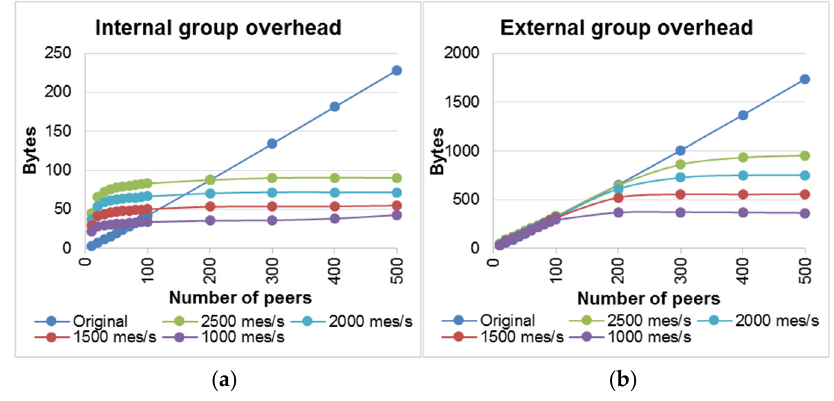
Figure 7. Internal ( a ) and external ( b ) group overheads in bytes for a system with delays from 0 to 50 milliseconds.